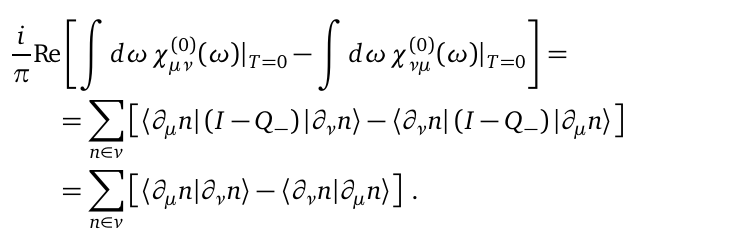
calculated in µν